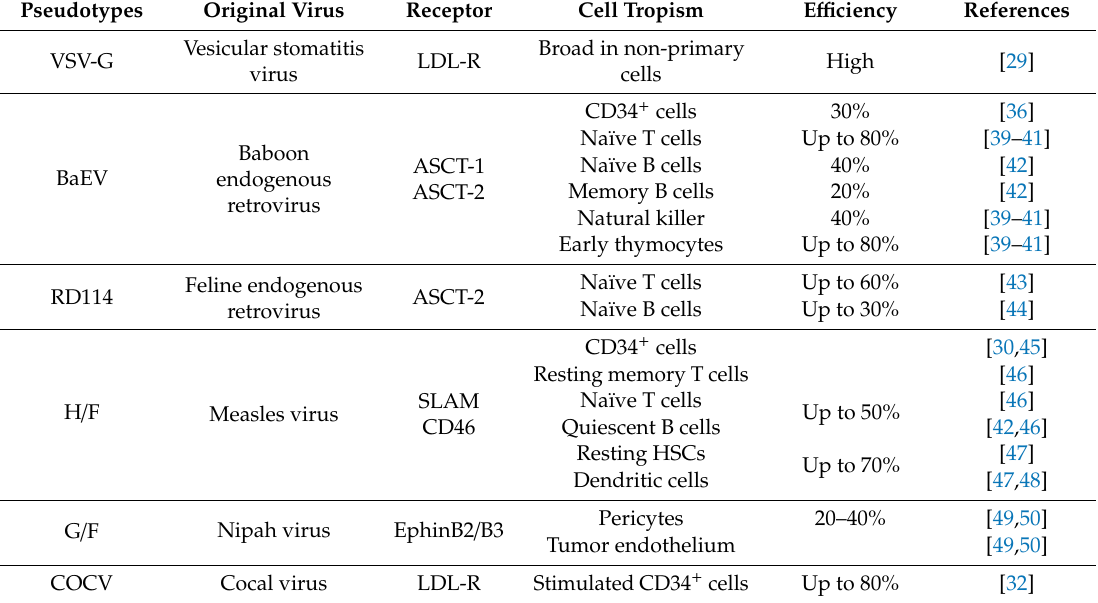
Table 1. Di ff erent viral envelope glycoproteins used for lentiviral vector pseudotyping and their cell